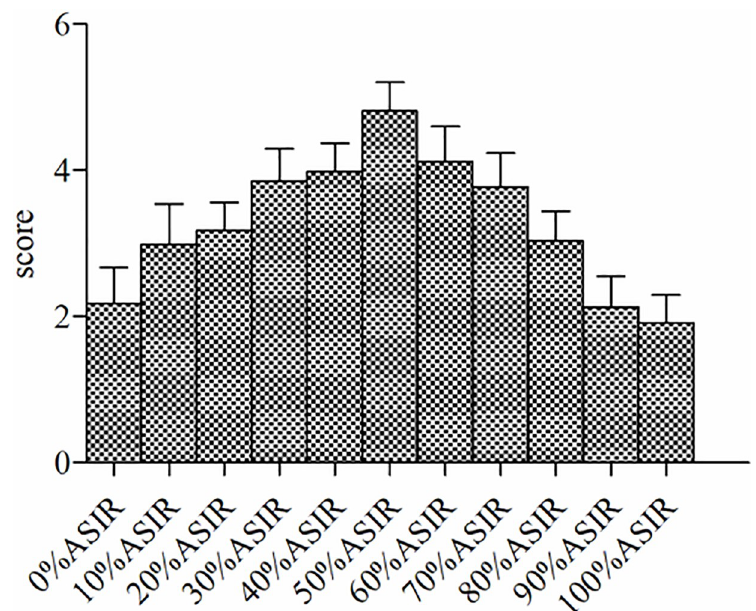
Fig 3. Overall image quality subjective with ASIR weight value curve. Fig 3 shows that the image quality of the ASIR weight value from 0% to 50% increases, and 50% to 100% decreases.